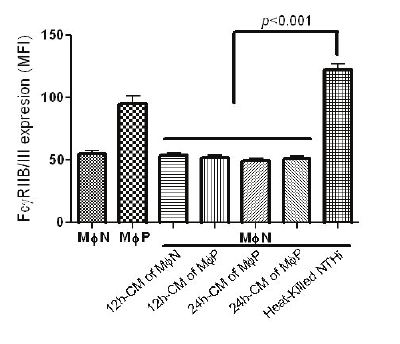
Figure 3. Fc γ RIIB/RIII expression in M φ N after treatment with M φ N or M φ P conditioned medium (CM). M φ N were treated with either 12 h- or 24 h-CM from M φ N or M φ P, or with heat-killed NTHi as control (see Materials and Methods for details). After 24 h, Fc γ RIIB/RIII was analyzed by flow cytometry. Results are expressed as mean ± 1 SD of mean fluorescence intensity in three independent